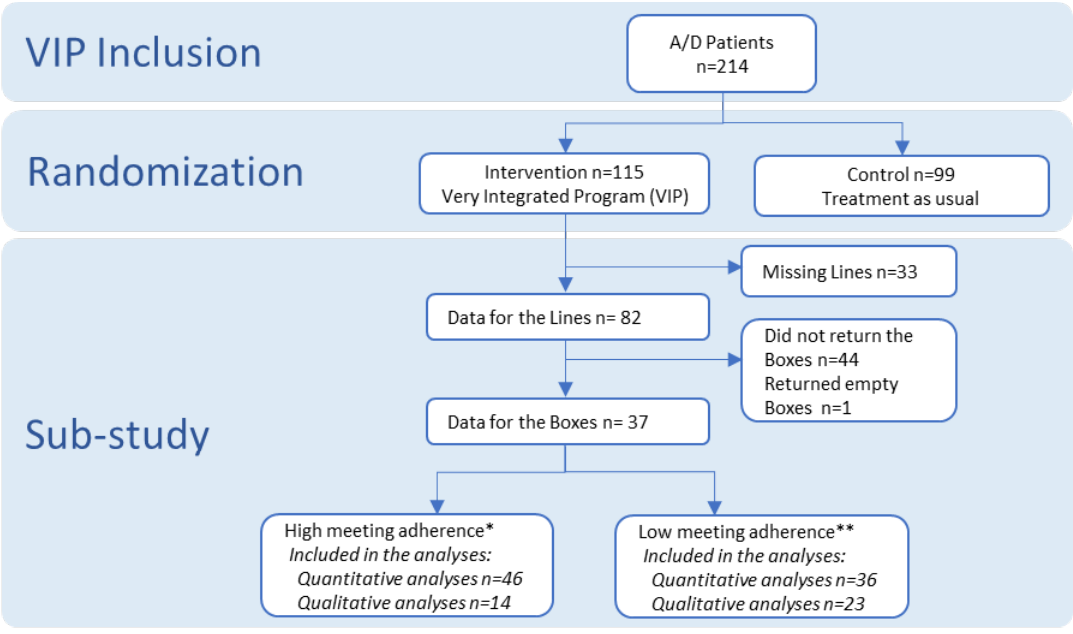
Figure 1. Study Profile. VIP: Very Integrated Program.